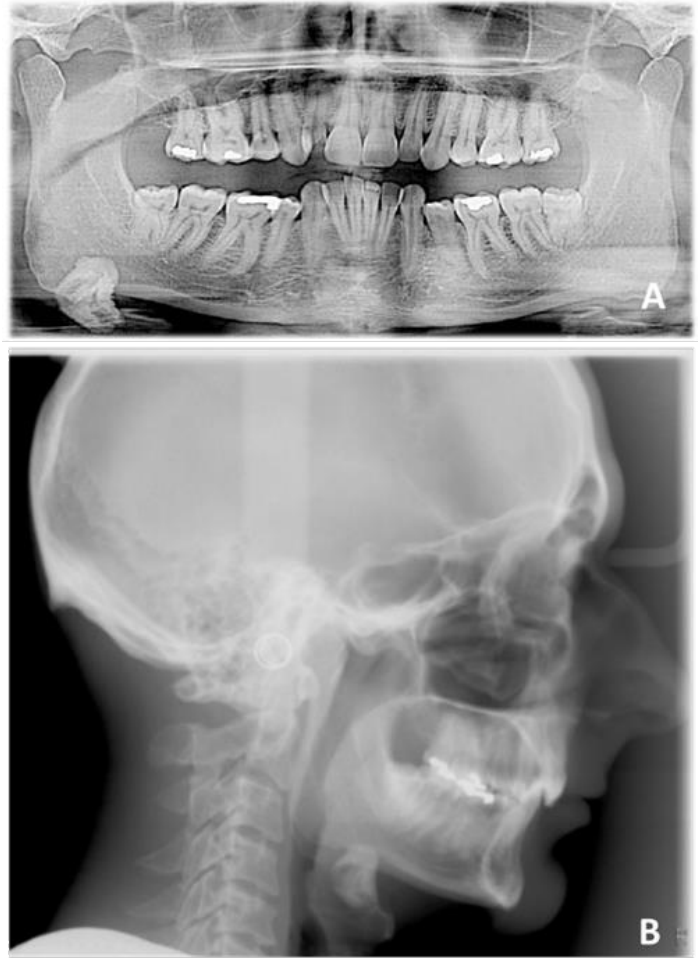
Figure 10. Pre-treatment radiographic of case number 1: ( A ) orthopantomography; ( B ) lateral cephalogram.